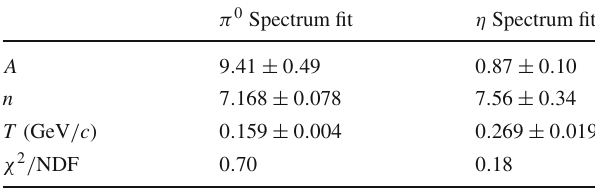
Table 5 Fit parameters and χ 2 / NDF of the Tsallis fits to the combined π 0 and combined η meson invariant differential